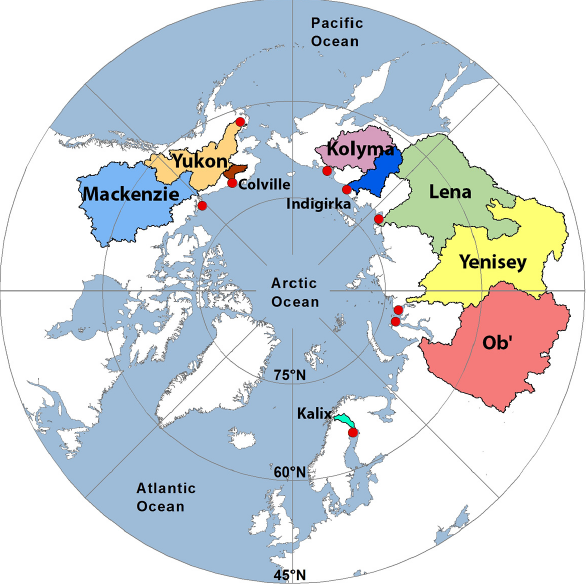
Figure 1. Sampling locations (red dots) and watersheds of the nine Arctic and sub-Arctic